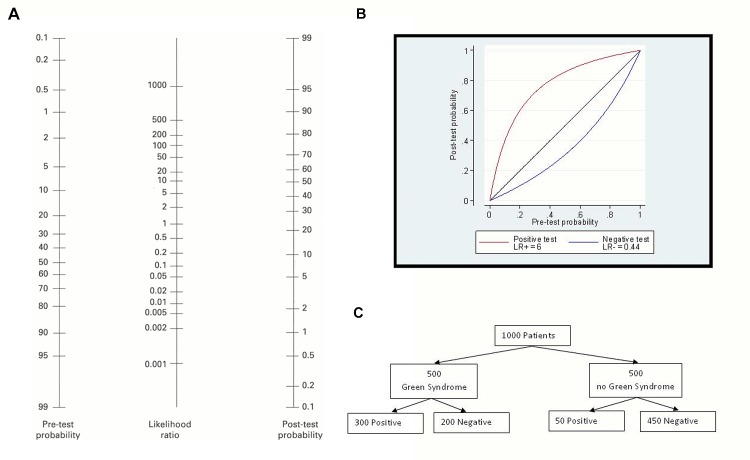
CONSORT flowchart.